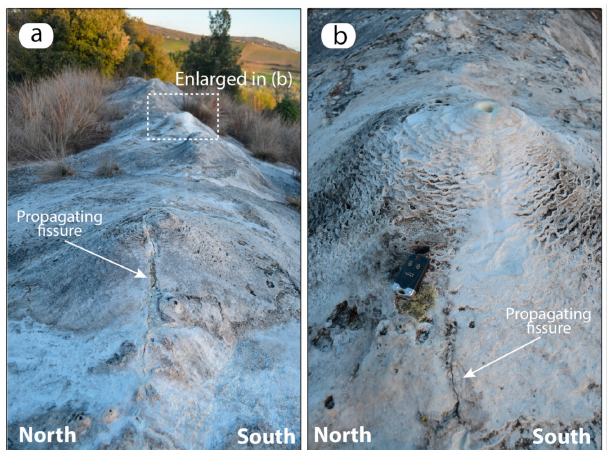
Figure 8. ( a ) Example of neoformational cones developed at the top of a fissure ridge cut by the propagating fissure (Terme San Giovanni fissure ridge, Rapolano Terme, Italy); ( b ) detail of the box indicated in ( a